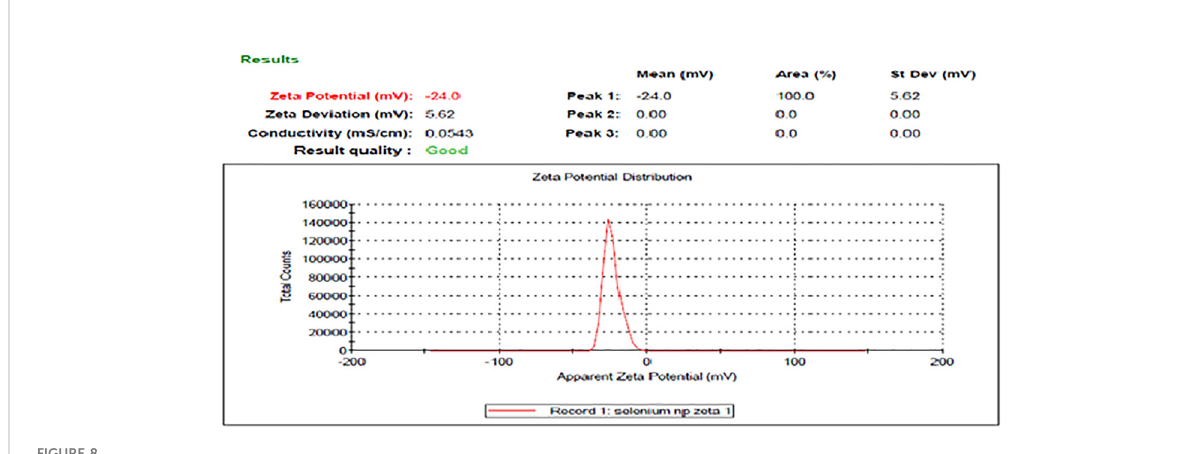
FIGURE 8 Zeta potential of the PoSeNPs.